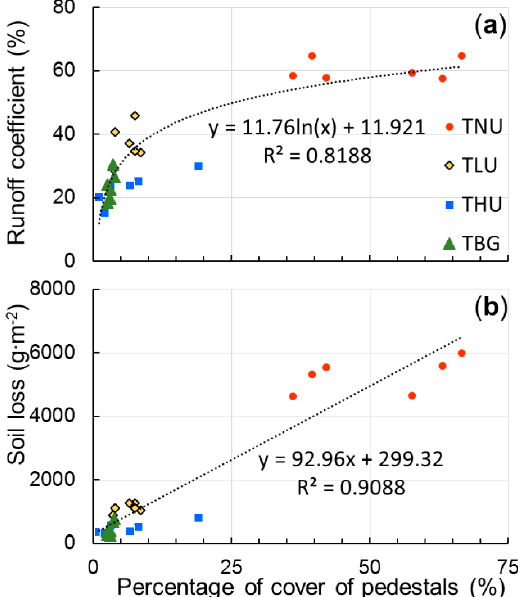
Figure 5. ( a ) Relationship between runoff coefficient (%) and percentage of cover of pedestal features (%). ( b ) Relationship between soil loss (g·m − 2 ) and percentage of cover of pedestal features (%) measured in 2017 in Ban Kokngew, Luang Prabang Province, Lao People’s Democratic Republic. TNU: teak with no understory; TLU: teak with low density of understory; THU: teak with high density of understory; TBG: teak with broom grass.